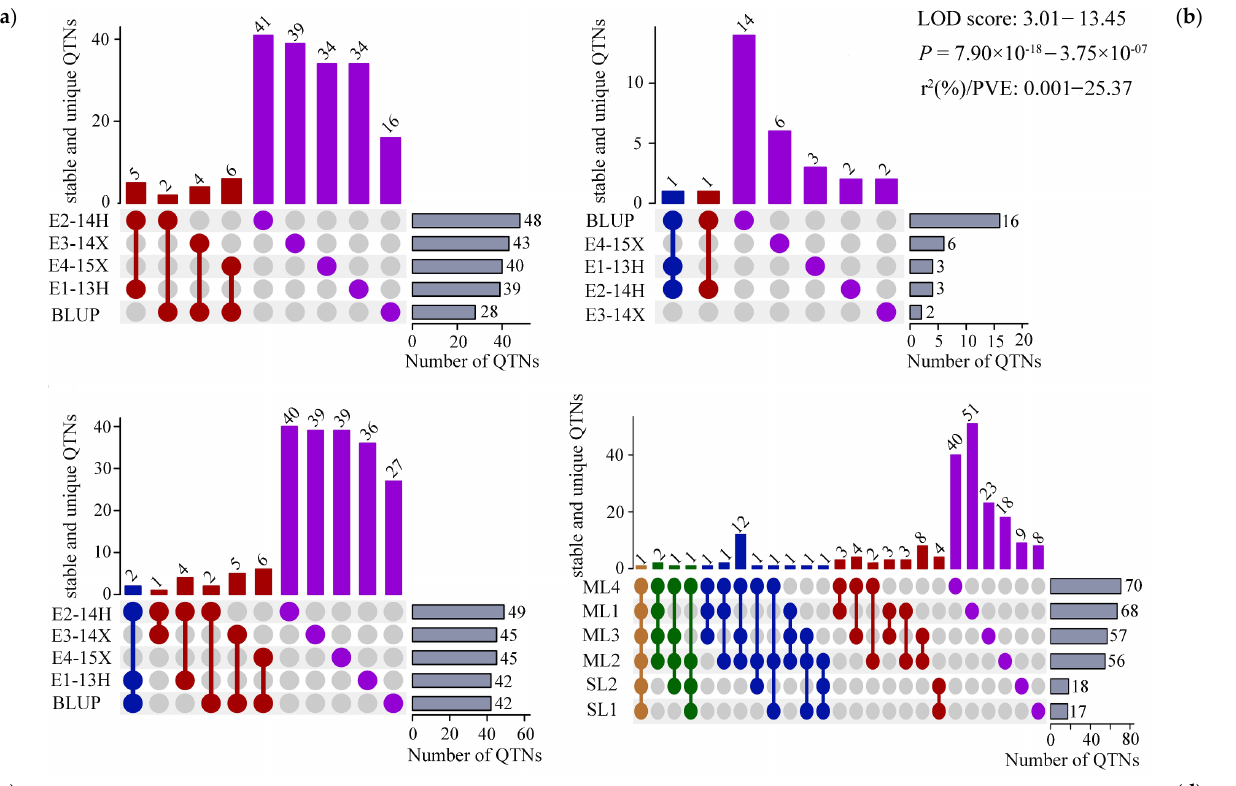
Figure 2. Total number of significant QTNs and common QTNs for plant height identified in four environments and GWAS models. Unique and common QTNs were identified in four environments and BLUP by ( a ) ML-GWAS models, ( b ) SL-GWAS models, and ( c ) combined ML/SL models. ( d ) All six methods detected unique and common QTNs. The connected circles below the histogram represent common QTNs; brown, dark blue, dark green, and dark orange represent two, three, four, and five common QTNs, respectively, while purple denotes unique QTNs. Horizontal bars show the total number of QTN set sizes for different environments and methods. E1-13H: Hukou (2013), E2-14-H: Hukou (2014), E3-14X: Xikou (2014), and E4-15X: Xikou (2015).